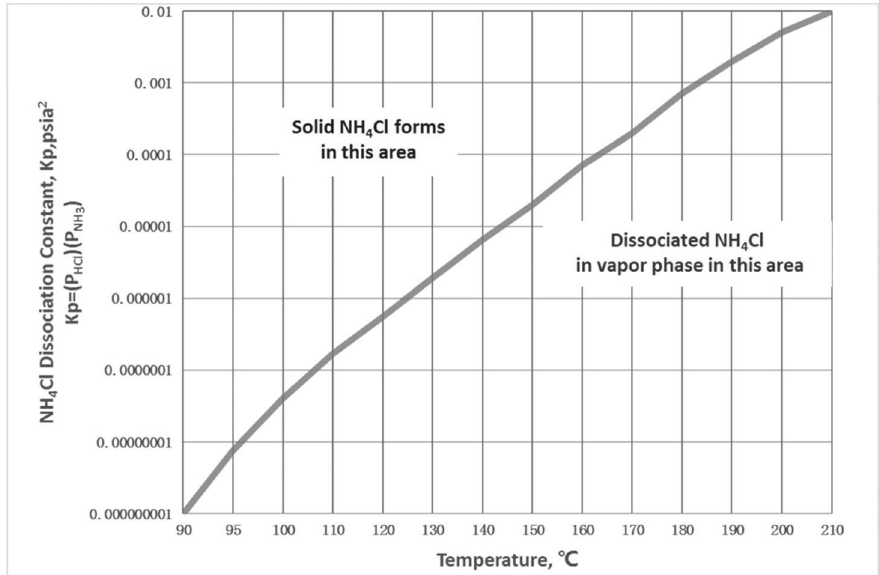
Figure 3. Measured data of ammonium chloride crystallization industry.